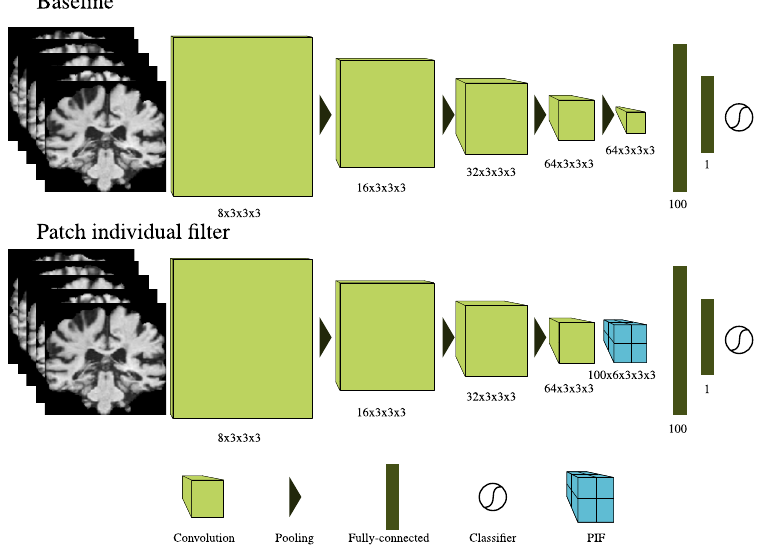
Figure 5. Overview of the CNN architecture, the top row shows the baseline which has been optimized for the respective task. The bottom row shows the same architecture with the last convolutional and pooling layer replaced by a PIF layer. Written below each convolutional layer are the number of filters and their size and below each fully-connected layer is the number of output neurons. Below the PIF layer the number of patches, number of convolutions per patch, and size of convolution kernels are displayed. Shown are model A and model A-PIF as used on the UK Biobank.